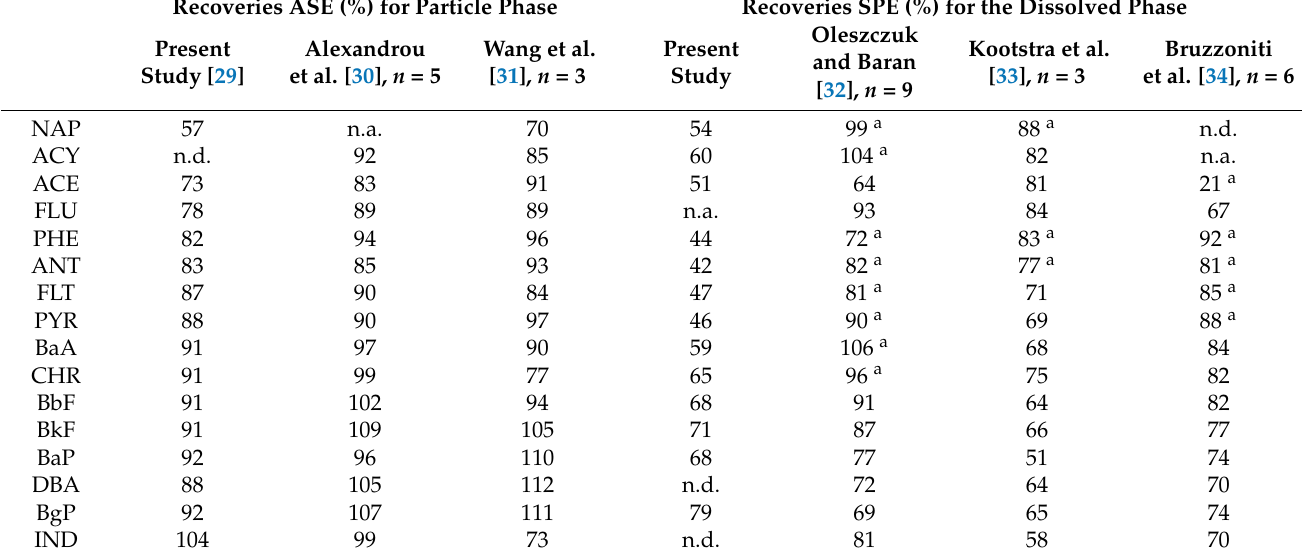
Table 2. Summary of the absolute recoveries (%; mean values) for ASE (for particulate phase extraction) and SPE (for dissolved phase extraction). The recoveries are compared to reports from literature. n.d. = not detected, n.a. = not